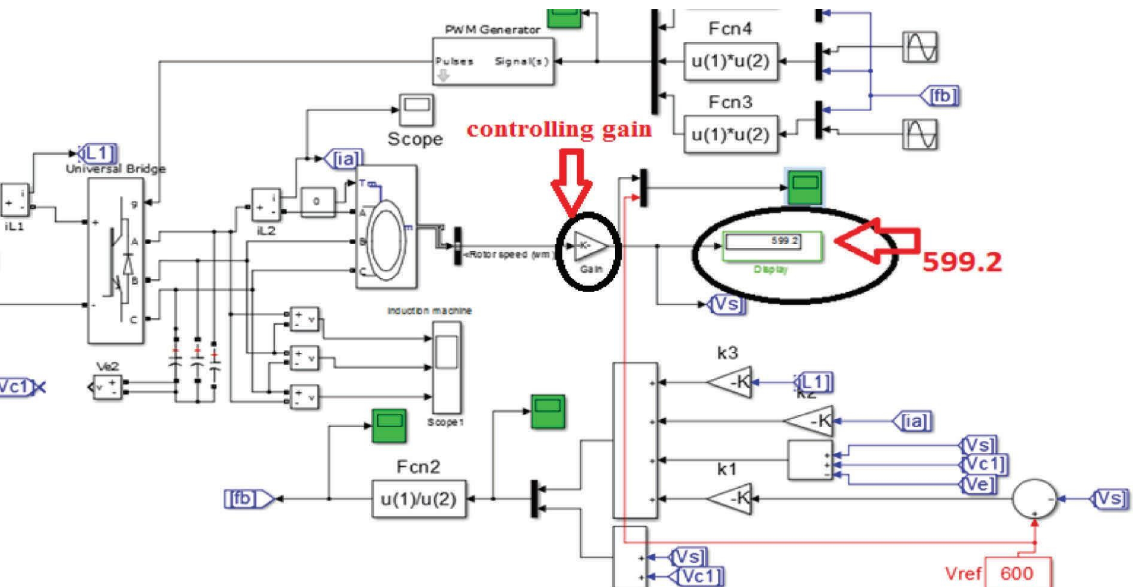
Figure 17: Simulink for SMC control for nominal speed of the